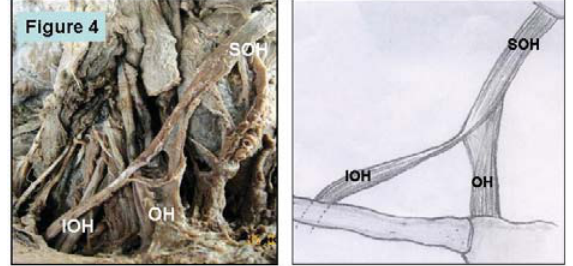
Figure 4 - Dissection of right cervical region showing fibres from sternum merging with the superior belly of Omohyoid: SOH - Superior belly of Omohyoid; IOH - Inferior belly of Omohyoid; OH - Fibres from